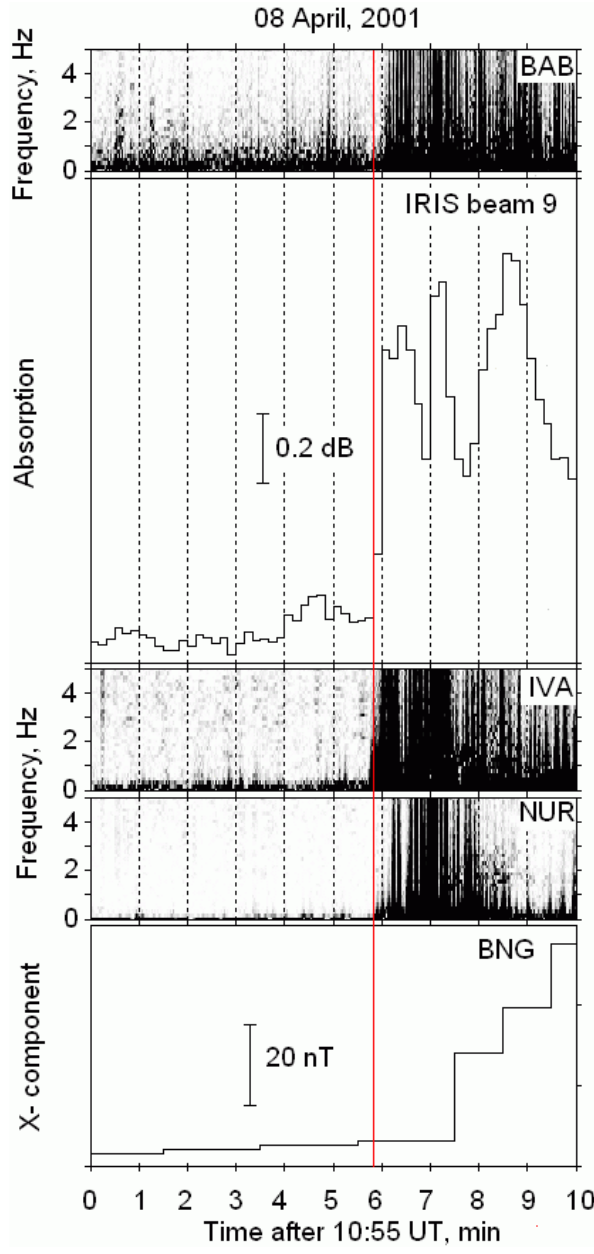
Fig. 12. Broadband enhancement of the ULF noise on meridional array of induction magnetometers. Red line indicates the time of